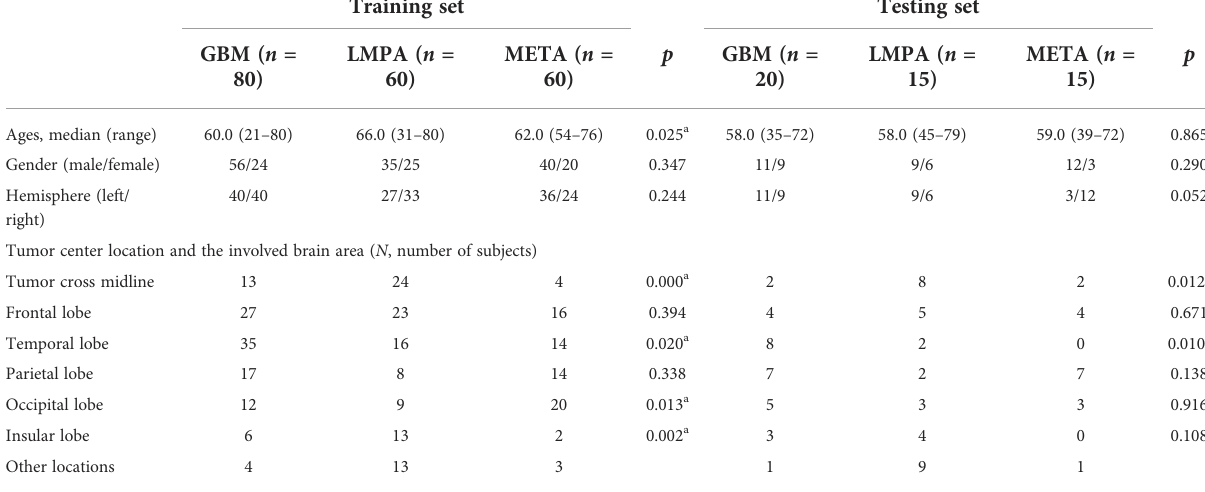
TABLE 1 The clinical characteristics of patients with central nervous system tumors in the training and testing sets. Training